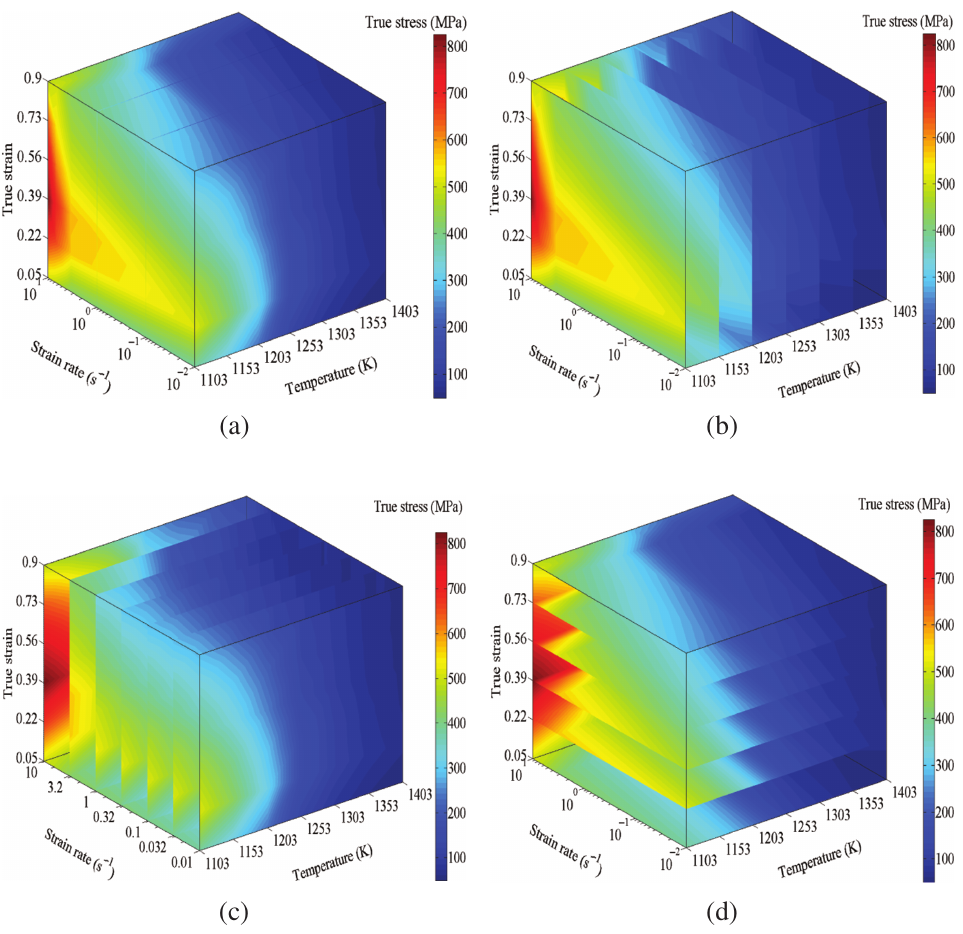
Figure 9: The 3D relationship among temperature, strain rate, strain and stress: (a) 3D continuous interaction space; 3D continuous response relationship under fixed (b) temperatures, (c) strain rates and (d) on V -axis, that is, the predicted true stress values under different deformation conditions are indicated by different colors. Figure 9(a) is a 3D continuous interaction space, a global expression of the 3D continuous response relation- ship. It covers all the deformation conditions and homo- logous predicted true stress values. Therefore, any true stress values in the deformation condition scope of 3D continuous interaction space can be read and accessed